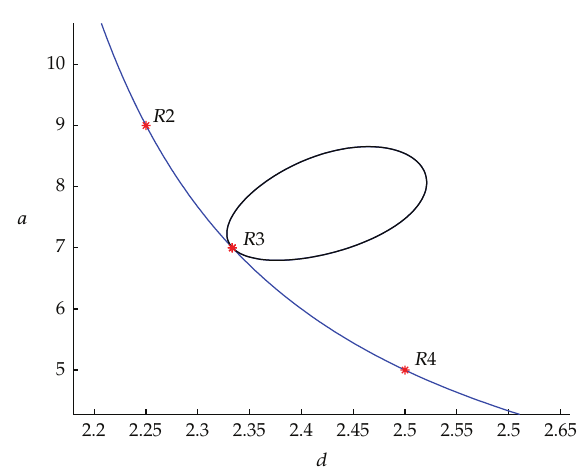
Figure 16: Curve of Neutral Saddle bifurcations of the third iterate for b (cid:8) 0 . 2.